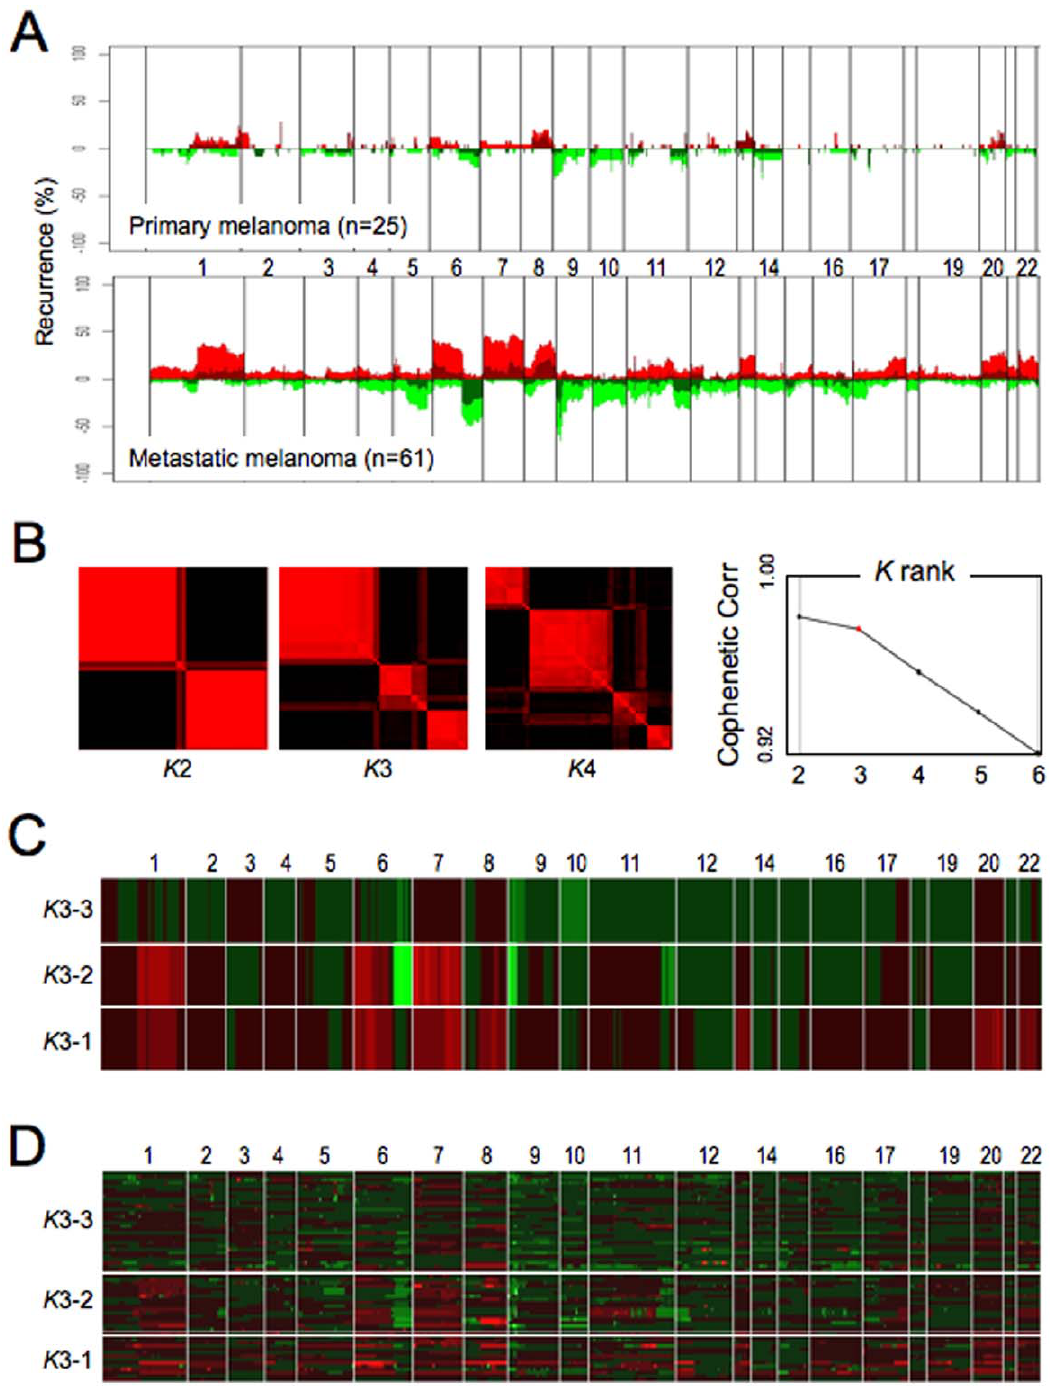
Figure 1. Array-CGH characterization of the primary and metastatic melanoma genomes. ( A ) Summary of genomic profiles of primary and metastatic melanomas and the recurrence of chromosomal alterations. Recurrence of CNAs across the samples in segmented data (y axis) is plotted for each probe evenly aligned along the x axis in chromosomal order. The percentage of tumors harboring gains, amplifications, losses and deletions for each locus is depicted according to the following scheme: dark red (gains with a log 2 ratio . =0.15) and green (loss with a log 2 ratio , = 2 0.15) and are plotted along with bright red (amplifications with a log 2 ratio $ 0.4) and bright green (deletions with log 2 ratio #2 0.4). ( B ) Consensus matrices show how often samples are assigned to the same clusters during 100 repetitions of gNMF, computed at K=2–4 for the 61 metastatic melanoma dataset. Each pixel represents how often a particular pair of samples clusters together, colored from 0% (black, samples are never in the same cluster) to 100% (red, samples are always in the same cluster). Ranks 2 and 3 classification show stable assignments into 2 and 3 blocks, respectively; in contrast, rank 4 assignments are disrupted. Cophenetic correlation coefficients for hierarchically clustered matrices in B. Valid clustering should show correlation close to 1. ( C ) gNMF classification with rank K=3 identifies three distinct subgroups. Array-CGH profiles of 61 metastatic melanomas were subjected to gNMF analyses (100 repetitions). Y axis indicates the centroid of three subgroups identified by gNMF. X axis coordinates represent genomic map order (from chromosome 1 to chromosome 22). The colors denote gained (red) or deleted (green) chromosome